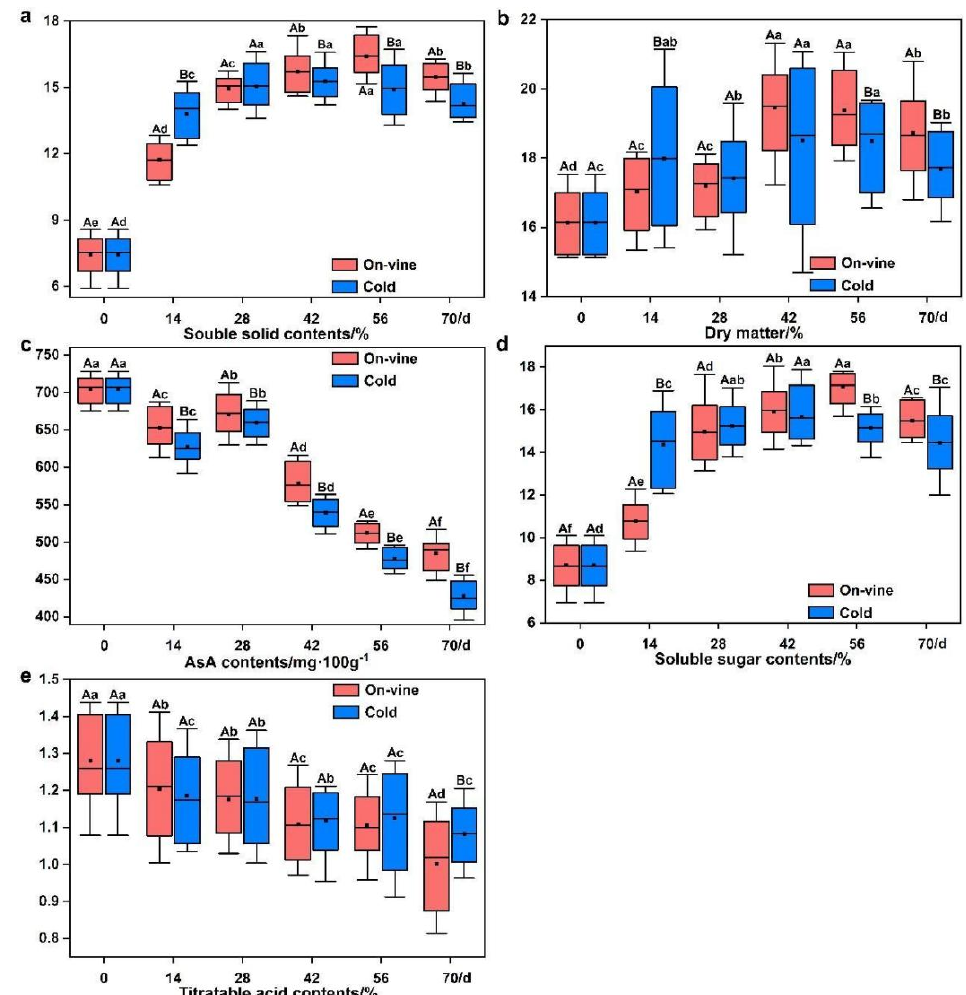
Figure 3. Changes in fruit quality with different softening methods. ( a ) Soluble solid contents. ( b ) Dry matter. ( c ) AsA contents. ( d ) Soluble sugar contents. ( e ) Titratable acid contents. Data are expressed as mean ± standard deviation of three biological repetitions. Error bars represent standard deviations of means. Different capital letters represent the difference between the two softening methods at the same harvest time, which are significantly different at p < 0.05. Different lowercase letters represent the difference in the different harvest times using the same method, which were significantly different at p < 0.05. Data were analyzed with Duncan’s multiple analysis.